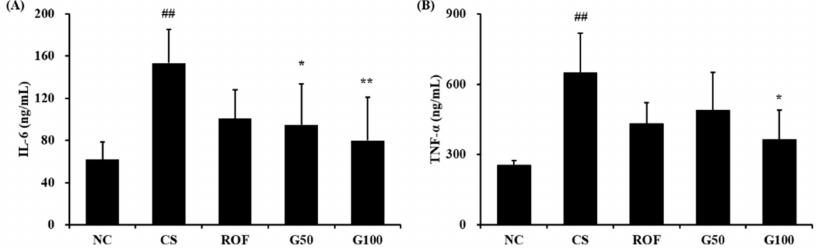
Figure 4. GGWE decrease the production of inflammatory cytokines. ( A ) IL-6 and ( B ) TNF- α . NC, non-treated mice; CS, CS and LPS exposure mice; ROF, roflumilast 10 mg/kg and CS and LPS exposure mice; G50, GGWE 50 mg/kg and CS and LPS exposure mice; G100, GGWE 100 mg/kg and CS and LPS exposure mice. The values shown are the mean ± SD. ## p < 0.01 vs. NC; # p < 0.05 vs. NC; ** p < 0.01 vs. CS; * p < 0.05 vs.